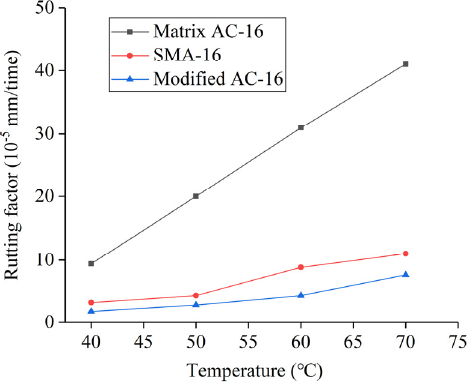
Figure 5. Variations of rutting factors of the three asphalt mixtures with temperature.